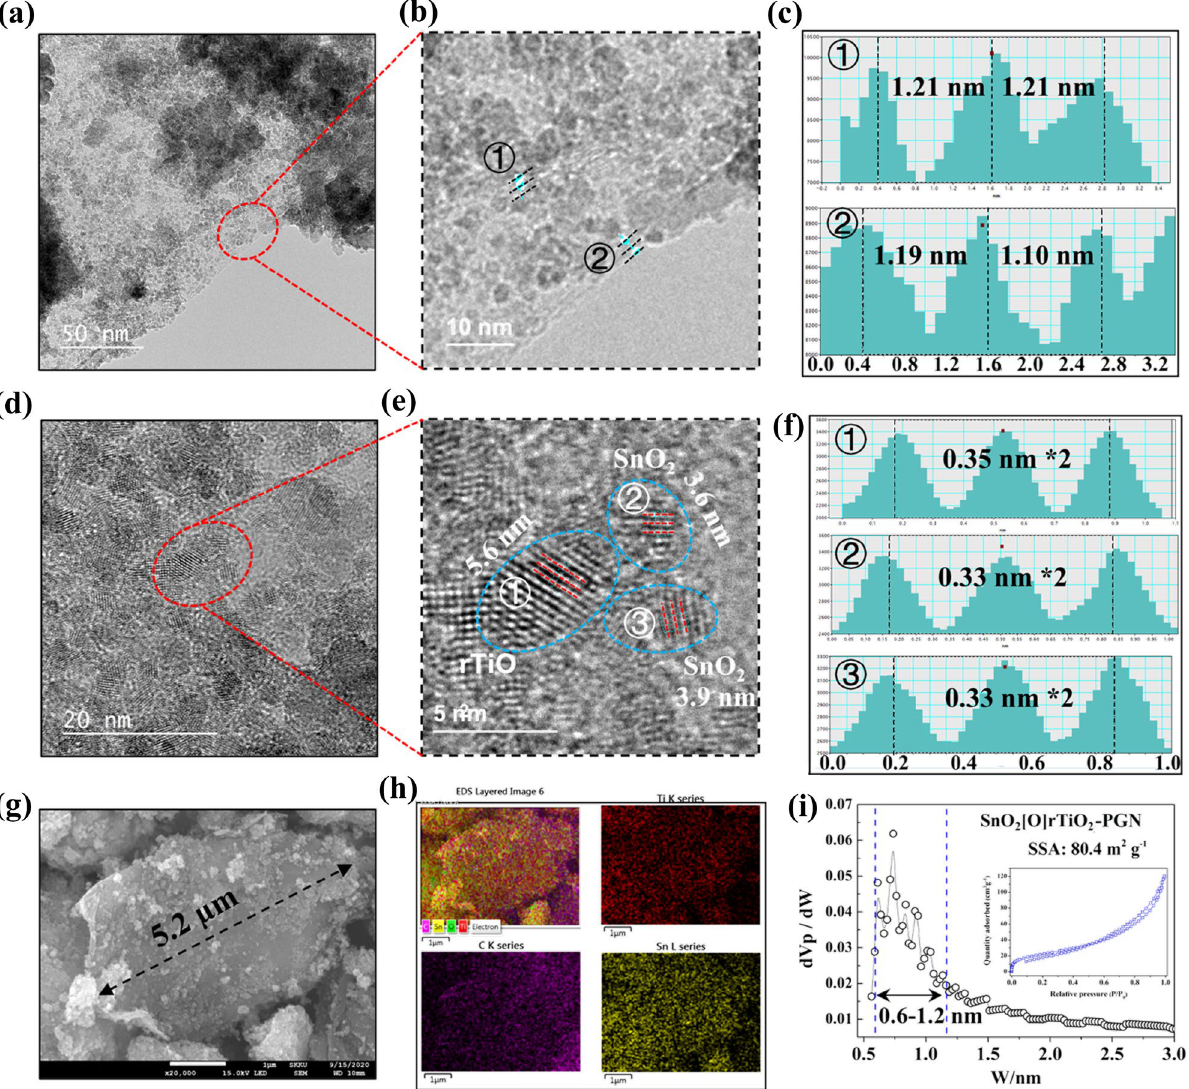
Figure 3. Morphology and microstructures of SnO 2 [O]rTiO 2 -PGN: ( a ) and ( d ) TEM images collected under lower magnification to present the overall structure. The areas in red circles are magnified in ( b ) and ( e ), respectively. The lattice spacing values of the number points are shown in the ( c ) and ( f ) contrast profiles. ( g )